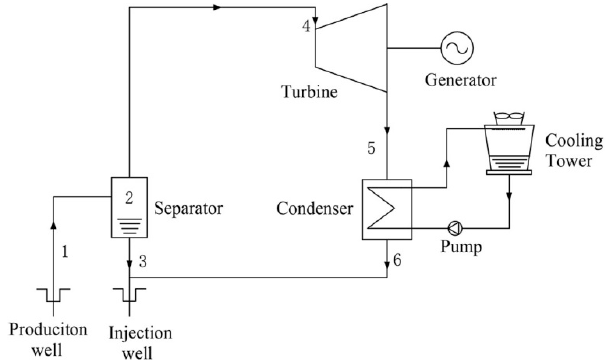
Figure 1. Single ‐ flash (SF) system.